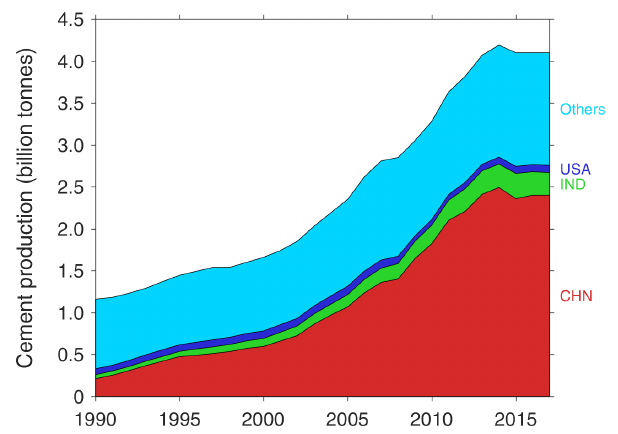
Figure C2. Production of cement by country, 1990–2017 (van Oss, 1994–2018; USGS, 2018).